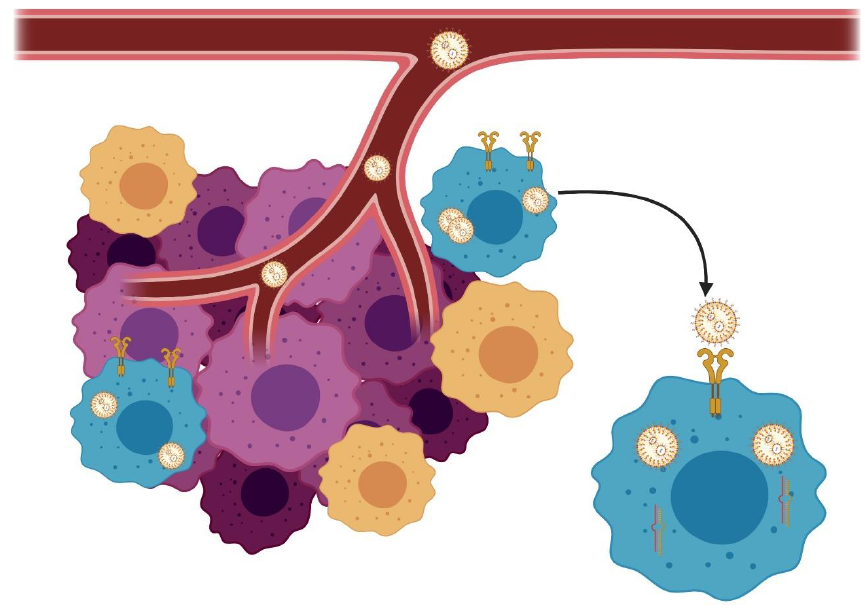
Figure 4. Representation of a solid lipid nanoparticle delivering small-interfering RNAs (siRNAs) in cancer cells. Through the blood vessels, nanoparticles can carry siRNA that can acts in specific BC cells, increasing the intracellular concentrations of the specific siRNA. Figure was created in BioRender (https://biorender.com/).